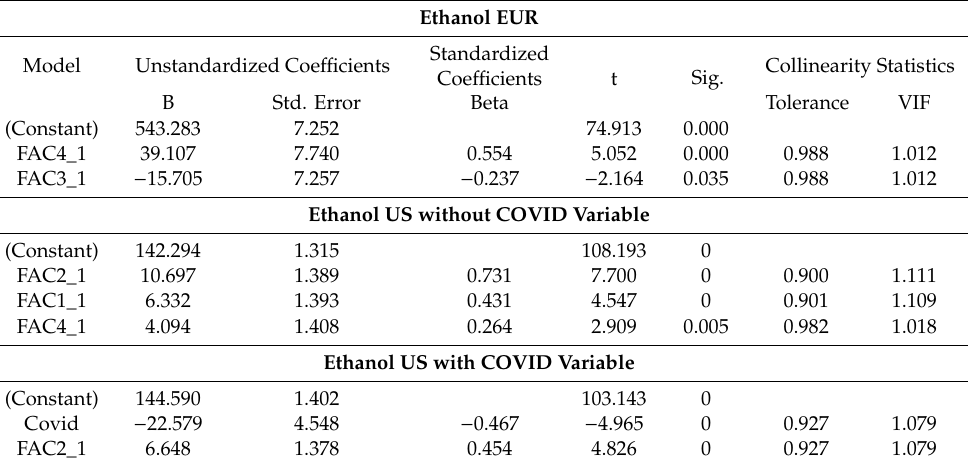
Table 8. Factor-based models of the ethanol